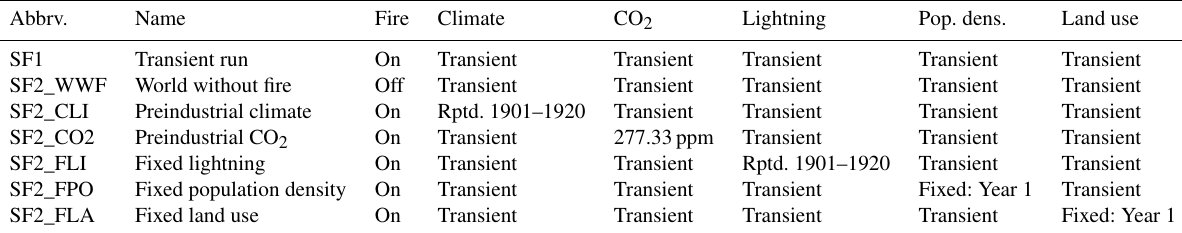
Table 1. Experiments run in this first phase of FireMIP. All experiments used repeated (rptd.) 1901–1920 climate forcings from the beginning of the simulation through 1900. “Year 1” refers to the first transient (non-spinup) year of the simulation, which is 1700 for all models except for CLM-Li (1850) and CTEM (1861).